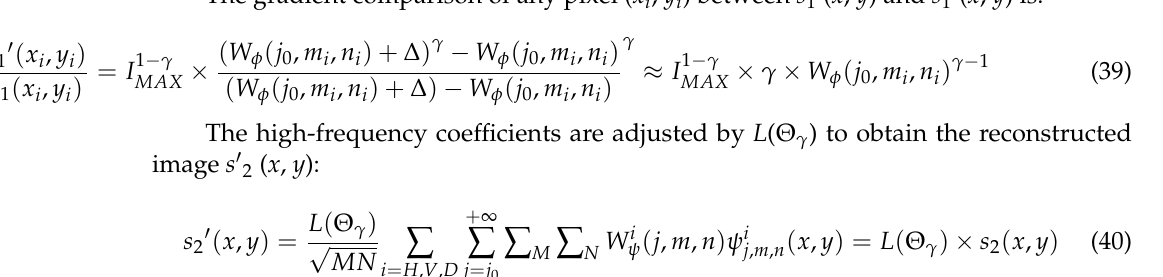
The gradient comparison of any pixel ( x i , y i ) between s 1 ( x , y ) and s 1 (cid:48) ( x , y ) is: